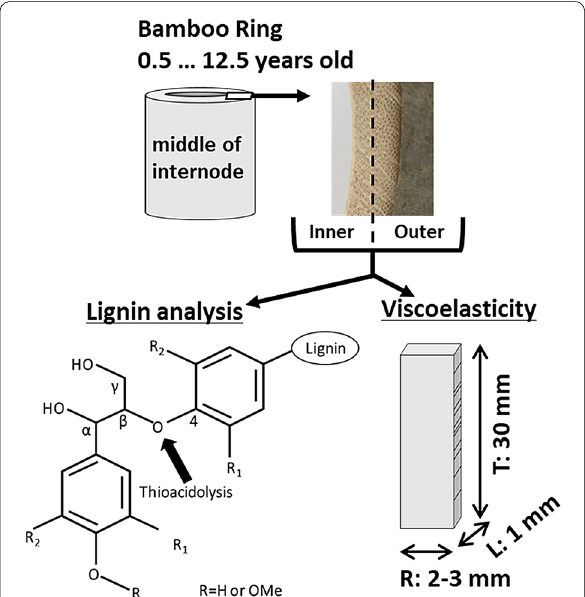
Fig. 1 Information on the samples used to measure dynamic viscoelasticity and lignin